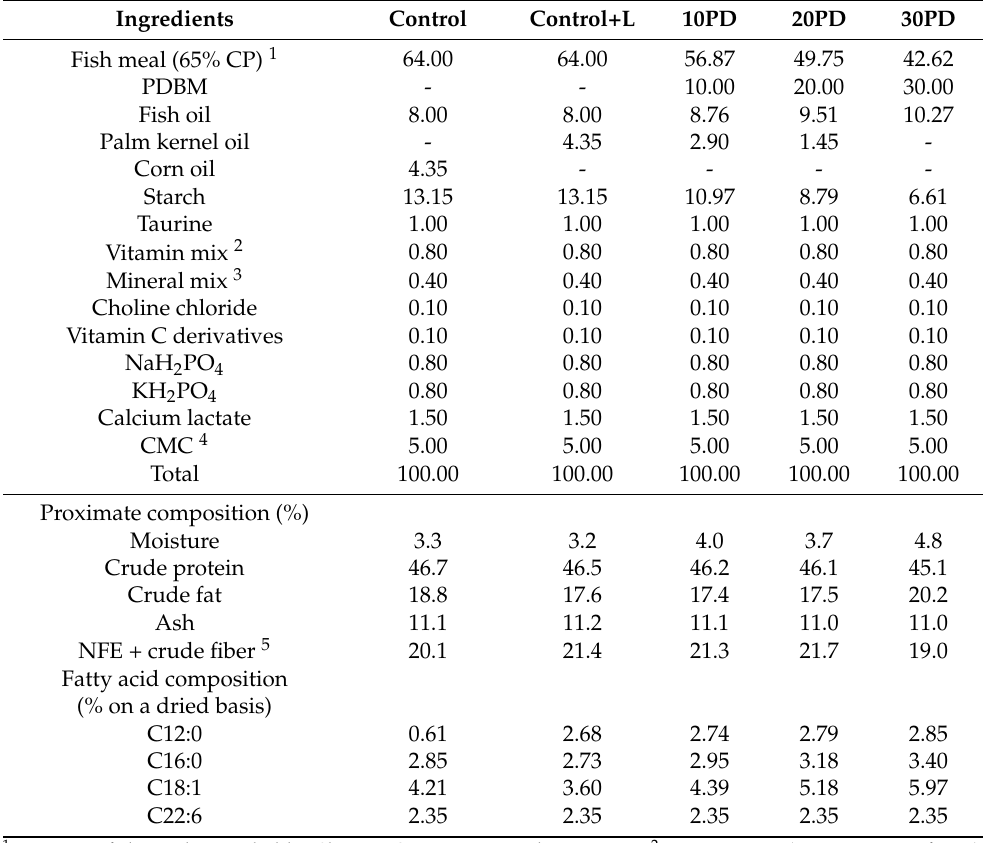
Table 1. Formulation of experimental diets in feeding trial